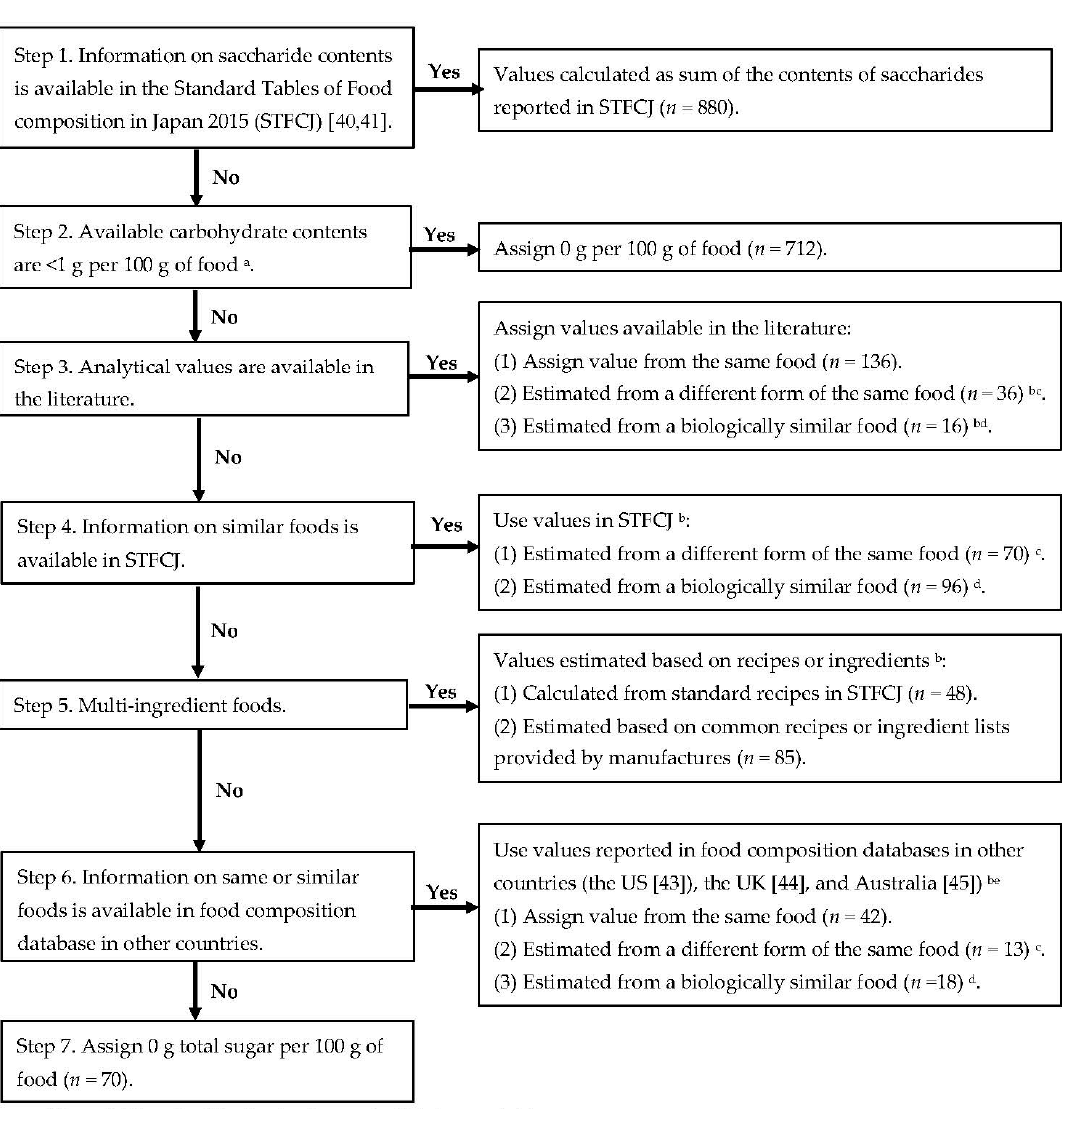
Figure 1. Flow chart for the development of total sugar database. a Available carbohydrate content was calculated as subtracting dietary fiber content (g/100 g of food) from carbohydrate that